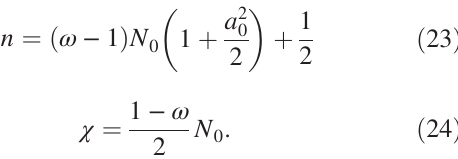
FIG. 3. Left: Normalized on-axis intensity spectra for different values of a 0 for the case of a laser pulse with duration τ pulse is properly chirped according to Eq. (18). Results obtained with the help of numerical integration are shown with solid lines. Markers of corresponding color present the analytical solution using Eqs. (16), (23) and (24). Right: Numerically obtained on-axis radiation spectra for a properly chirped laser pulse for different values of a 0 (vertical axis) in the logarithmic